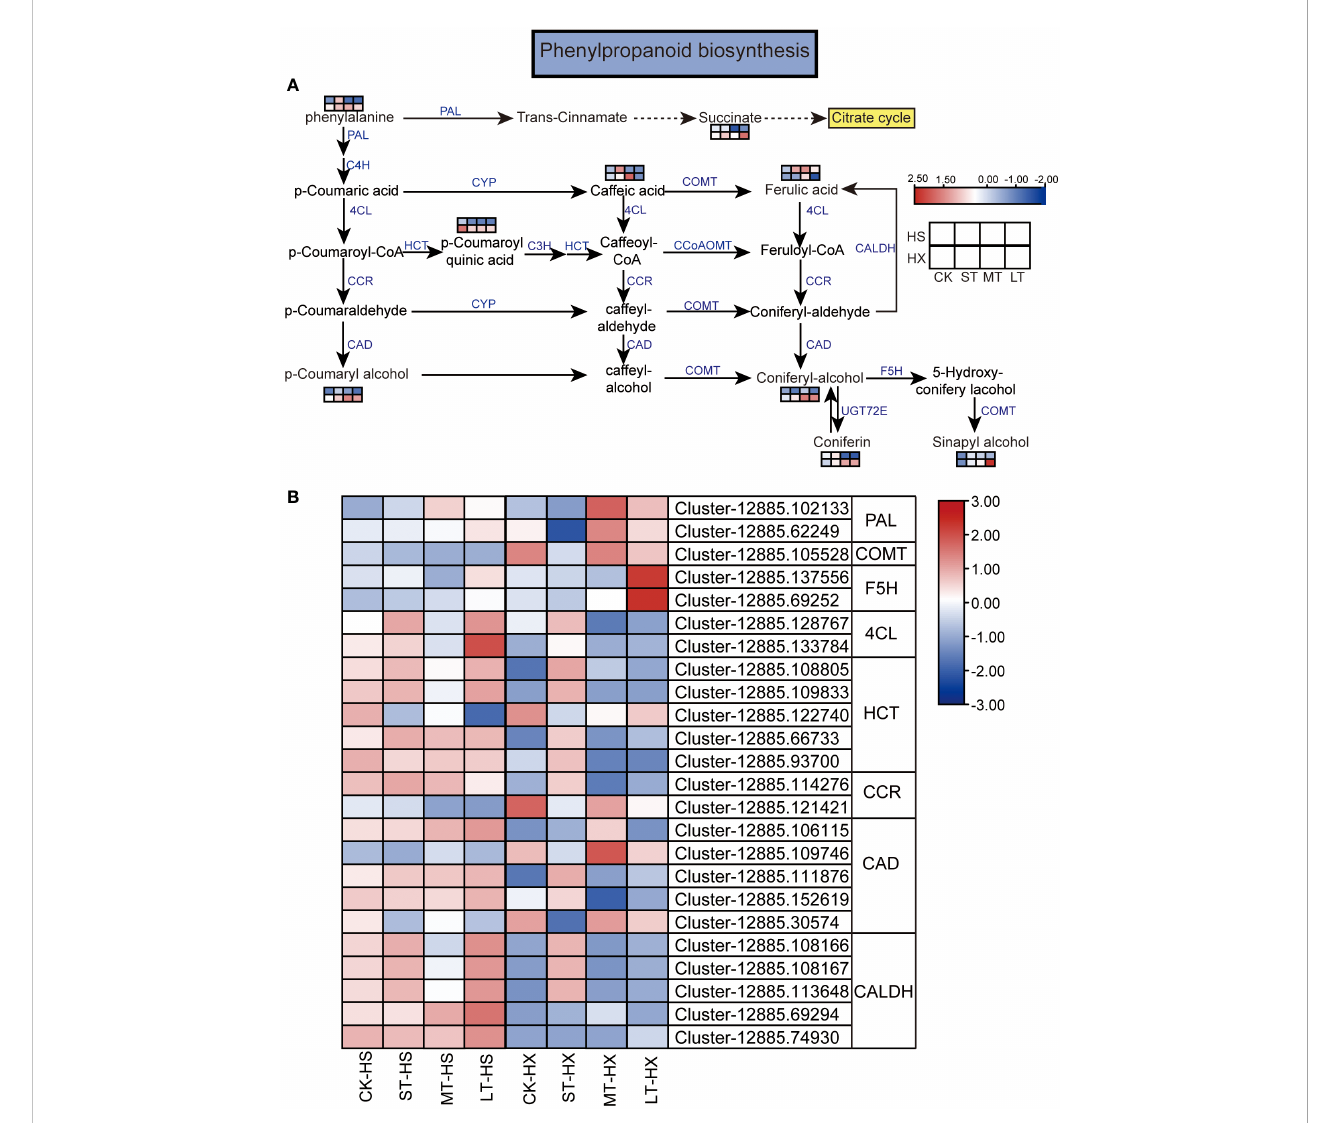
FIGURE 8 KEGG pathway annotation diagram of the phenylpropanoid biosynthesis pathway of DEGs and DEMs. (A) Schematic diagram of the KEGG pathway for the enrichment of DEGs and DEMs involved in phenylpropanoid biosynthesis. Blue text indicates enzymes, black text indicates metabolites, and the dotted lines indicate the omission of certain reactions. (B) Heatmap showing the expression of DEGs. Box color indicates the expression level of each gene: blue = decreased expression and red = increased